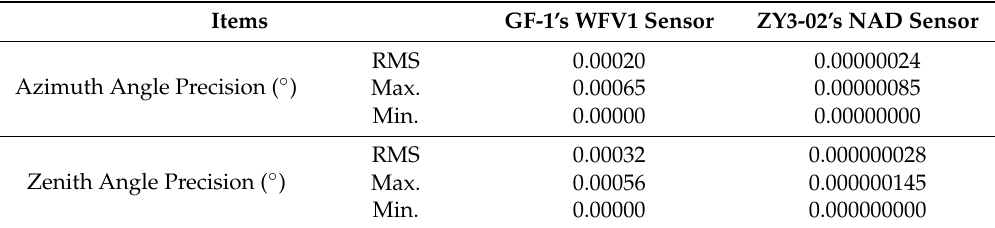
Table 3. Precision of the viewing angles using the proposed